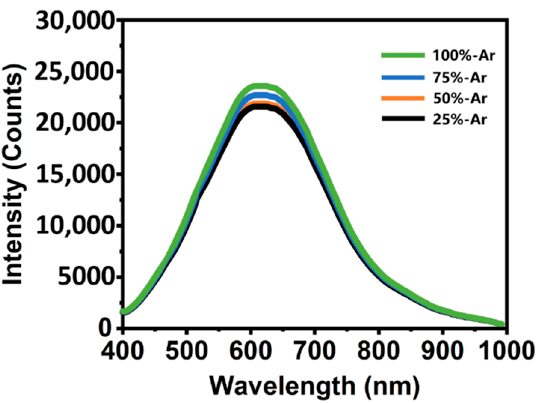
Figure 3. The PL spectrum of IGZO at different deposition atmospheres.